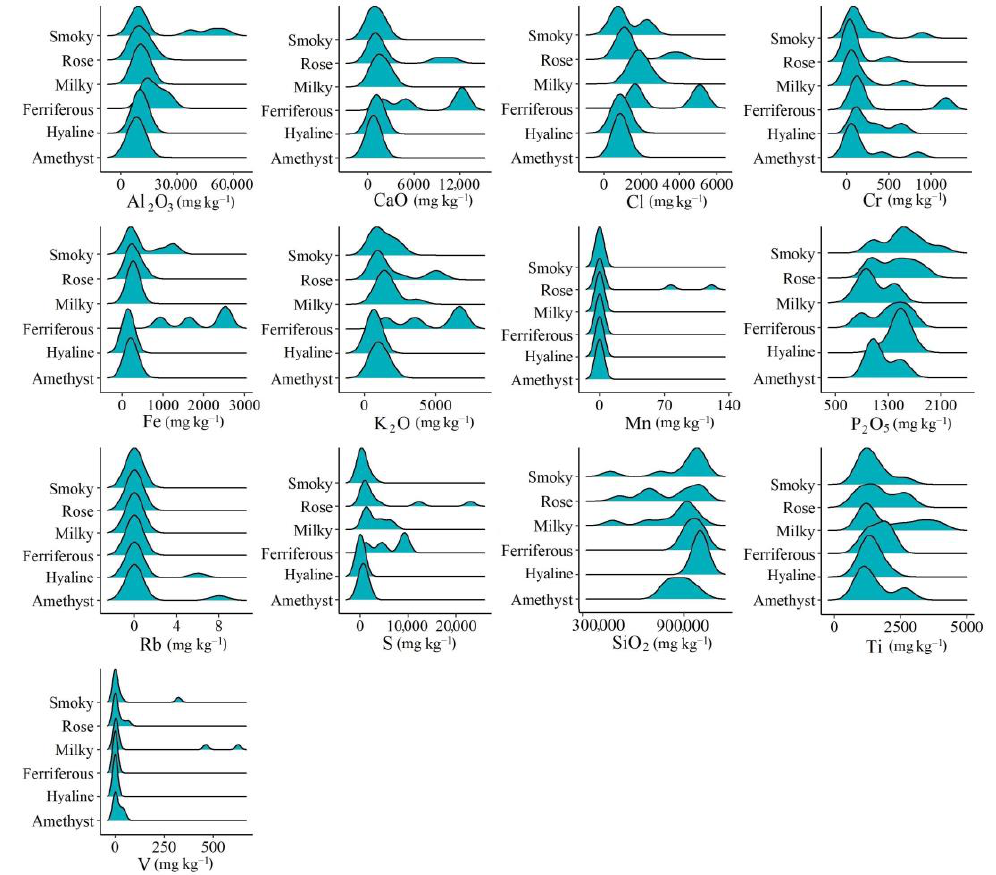
Figure 2. Distribution of contents of elements and oxides obtained by p XRF spectrometry for the 16 quartz samples from the Minerals and Rocks Collection of the Department of Soil Science of the Federal University of Lavras (UFLA).